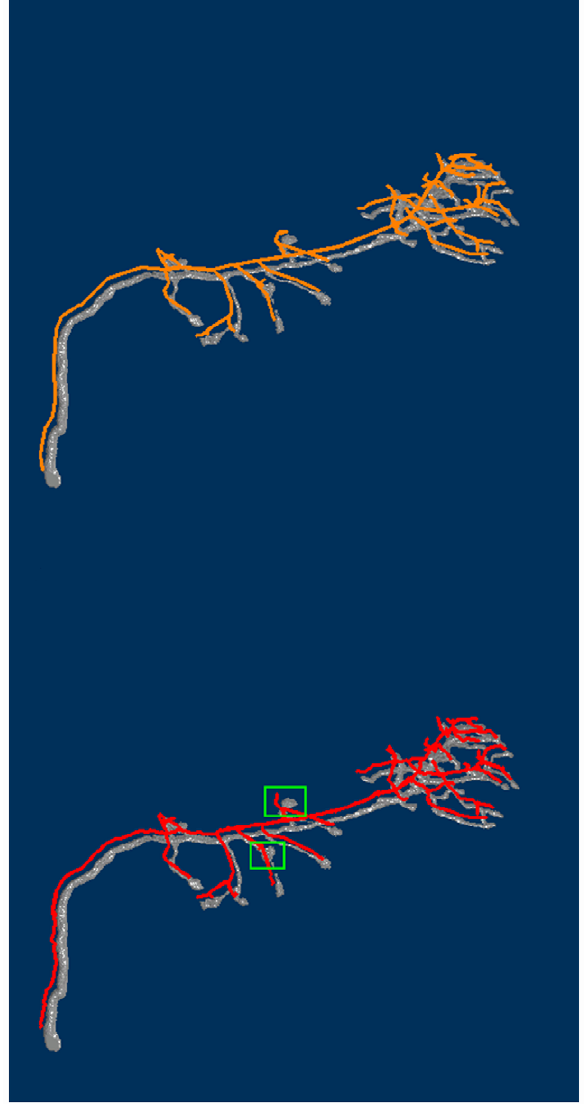
Figure 5. Both the gold reconstruction (top) and our tracing result (bottom) overlap with the volume rendering of the original image stack are shown. The green rectangles indicate the regions where the large distances occur.